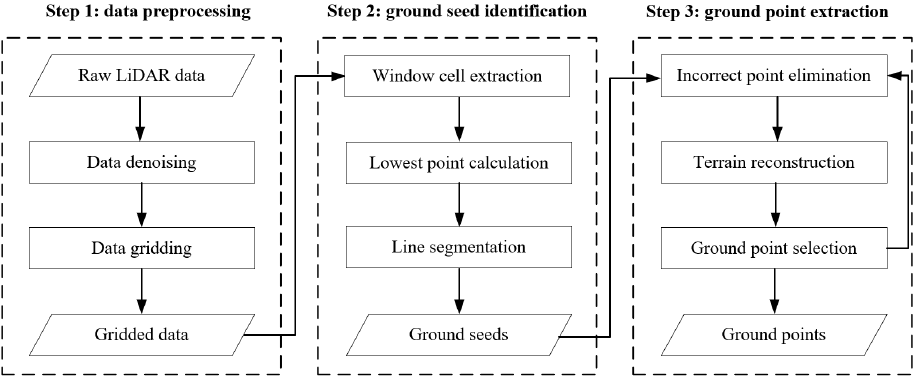
Figure 6. Workflow of the proposed method for filtering airborne LiDAR data in forested environ- ments.